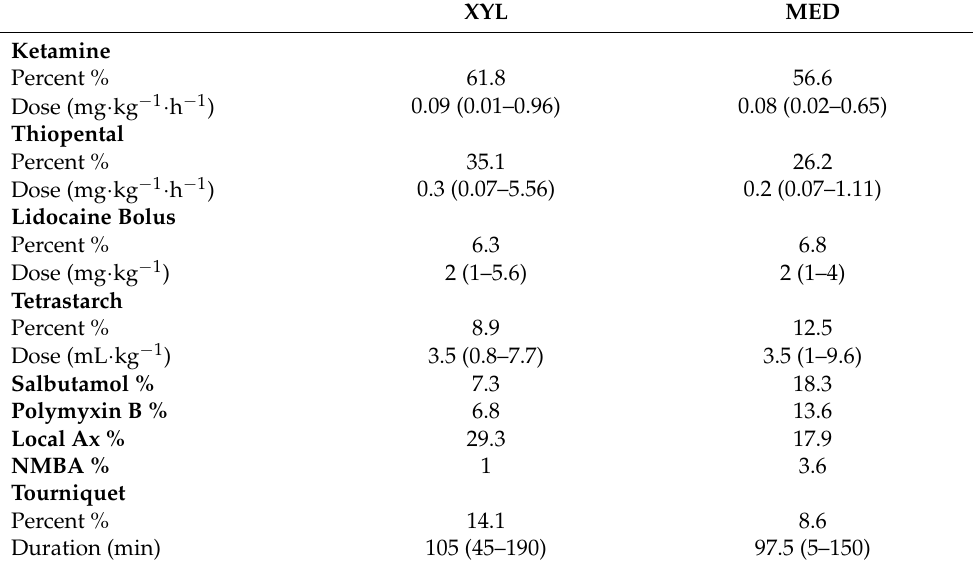
Table 3. Distribution of intraoperative measures and medical treatment for horses undergoing general anaesthesia with either isoflurane–xylazine partial intravenous anaesthesia (PIVA) (XYL, n = 191) or isoflurane–medetomidine PIVA (MED, n = 271). Data are presented as median (range). Local Ax = local anaesthesia and/or analgesia; NMBA = neuromuscular blocking agent.